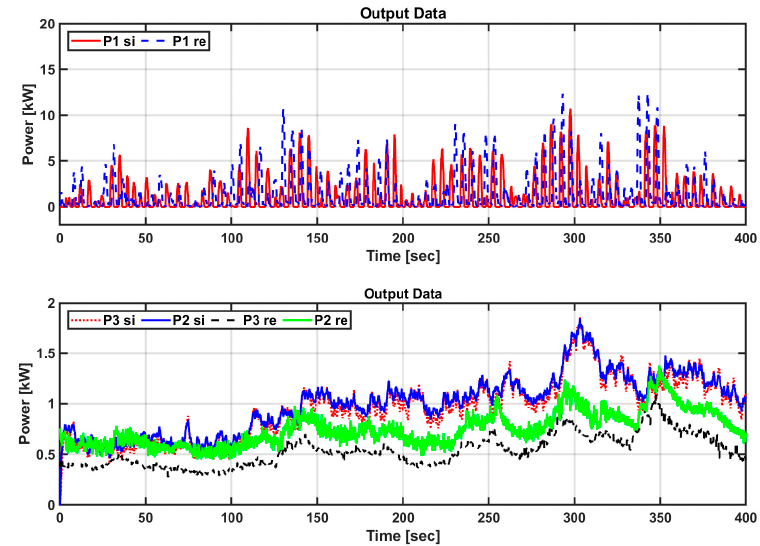
Figure 31. Comparison of power generation in actual sea test and simulation results.